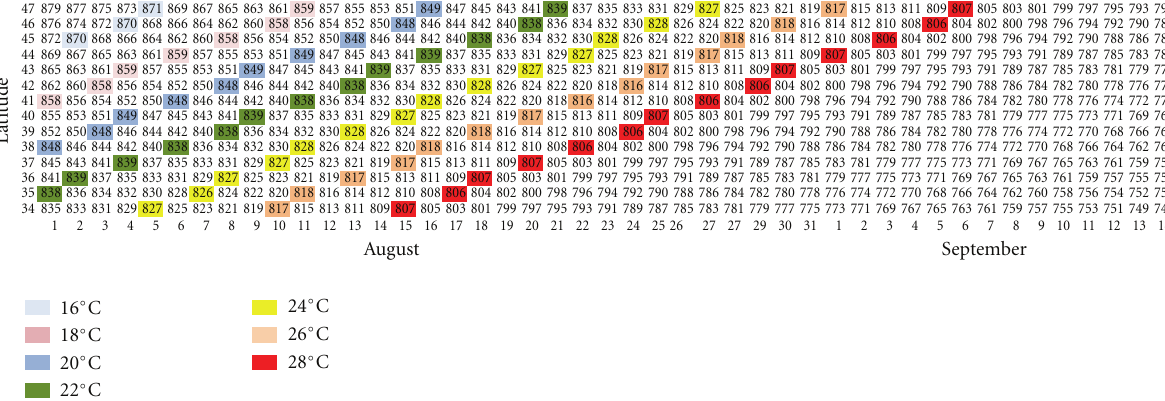
Figure 2: Variation in the length of the day, in minutes, from 1 August to 15 September according to latitude. Length of the day in color indicates the day of the critical photoperiod inducing 50% diapause for this temperature and latitude.